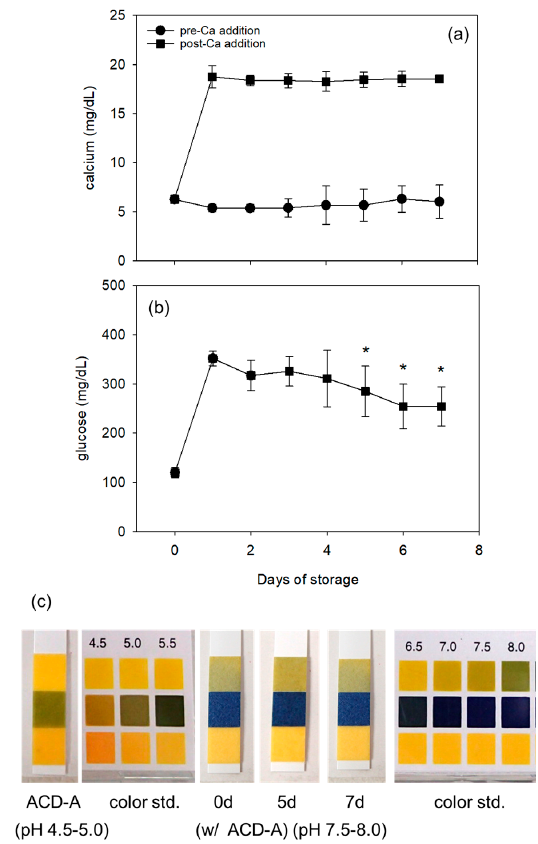
Figure 4. Stable Ca 2+ ( a ) and glucose levels ( b ) and pH ( c ) of fresh and stored WB samples. Because stored WB samples contained ACD-A as an anticoagulant, CaCl 2 was added to the samples for PRF clot formation. Ca 2+ levels were determined before and after the addition of CaCl 2 . Glucose levels were determined in WB samples before the addition of CaCl 2 . * p < 0.05 as compared with the individual control levels on day 1 ( n =